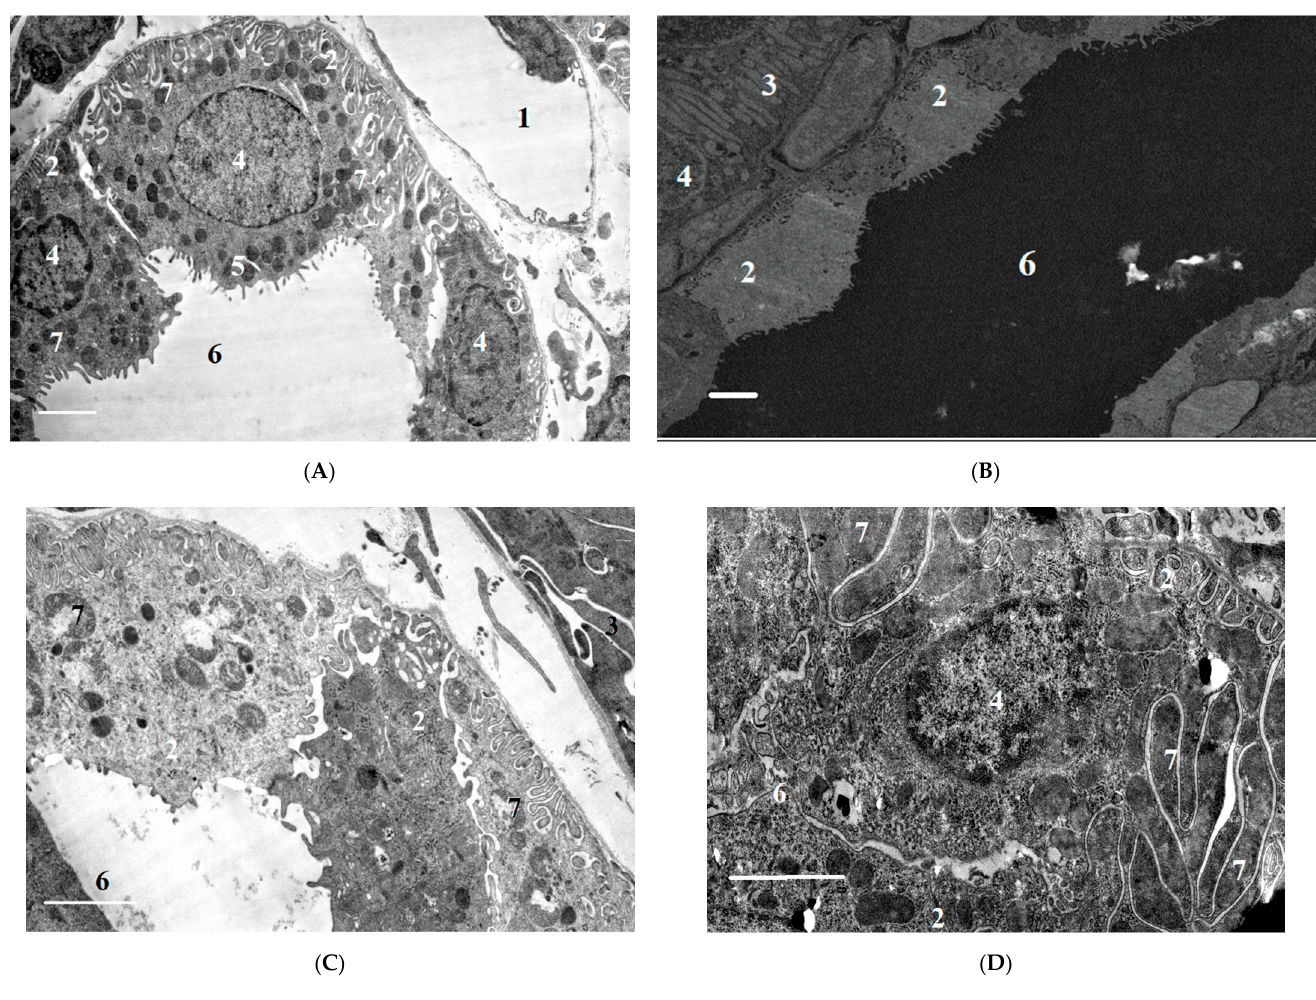
Figure 11. ( A )—control; ( B )—LD50, 24 h after exposure to POX; ( C )—LD84, 24 h after exposure to POX; ( D )—LD84, 3 days after exposure to POX. ( B,C )—decrease in height of epithelial cells of distal convoluted renal tubules 24 h after exposure to POX ( p < 0.05), and reduction in tubule lumen 3 days after exposure to POX ( D ) ( p < 0.05); ( C )—mitochondrial degra- dation. 1—capillary lumen, 2—epithelial cell of distal tubule, 3—epithelial cell of distal tubule, 4—nucleus, 5—mi- crovessels, 6—tubule lumen, 7—mitochondria. Double contrasting with lead nitrate and uranyl acetate. TEM, scale bar = 2 µm.